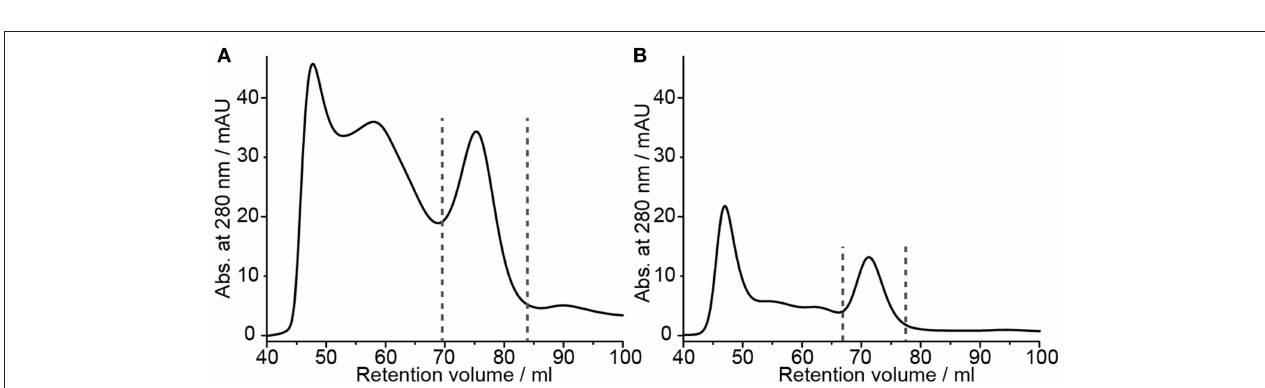
FIGURE 3 | NMR sample preparation of barttin in 1 5 NDs. (A) SEC profile of up-scaled barttin-NDs (MSP1 1 5) assembled with “native-like lipid mix” upon on-column biobeads adsorption. (B) SEC profile of up-scaled barttin-NDs (MSP1 1 5) assembled with DMPC upon dialysis. Dotted line mark fractions collected in the corresponding NMR